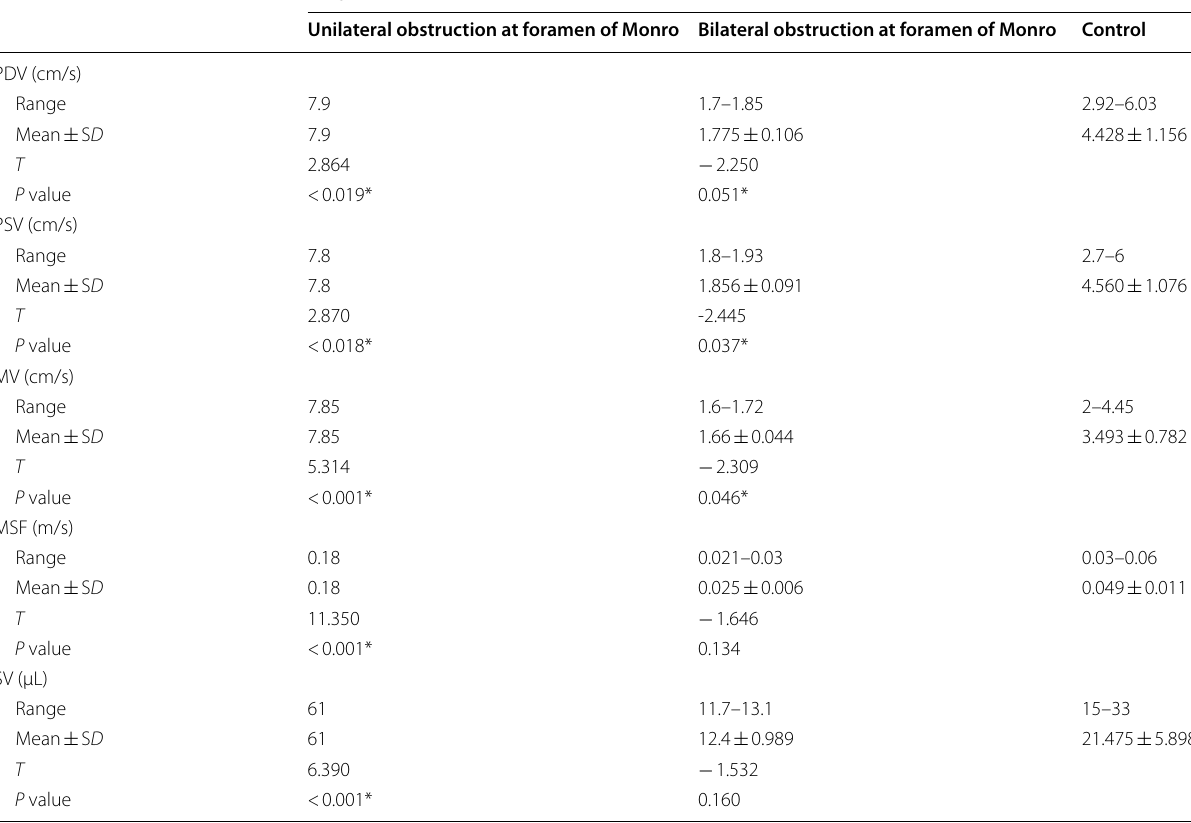
Table 4 Comparison between control group and patients with obstruction at the level of foramen of Monro regarding velocity and flow